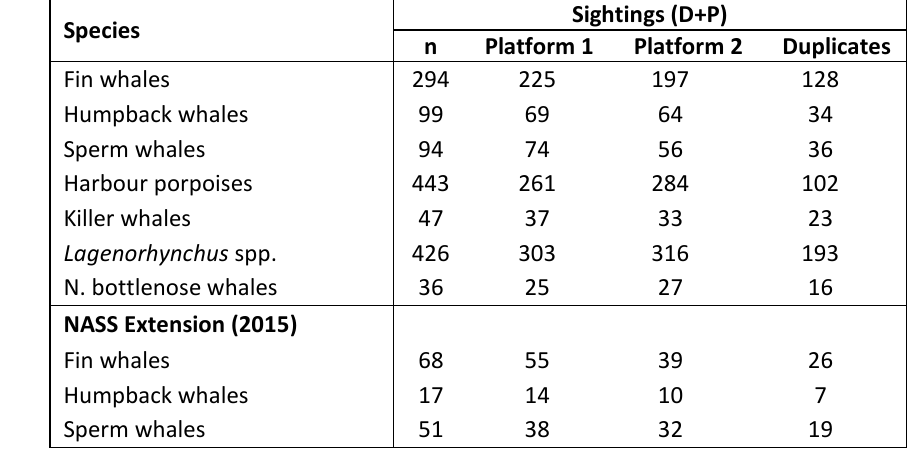
Table 5. The total number of sightings (n), sightings by platform, and duplicate sighting for each species using definite + probable (D+P) duplicates.